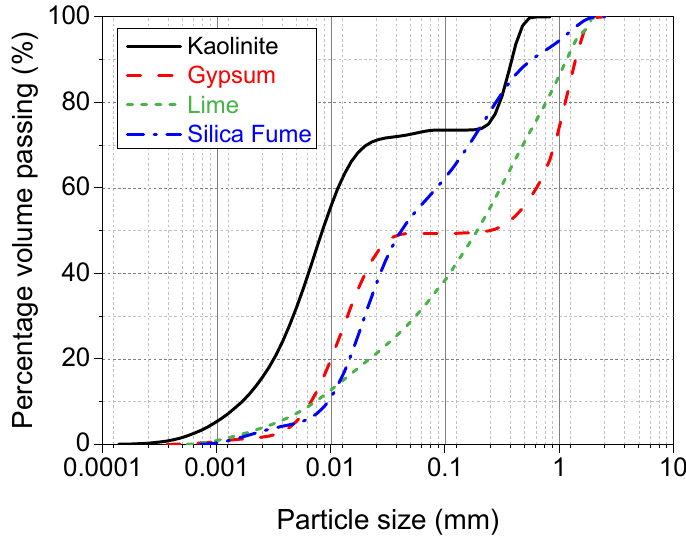
Figure 1. Particle size distribution of kaolinite, gypsum, lime, and silica fume.